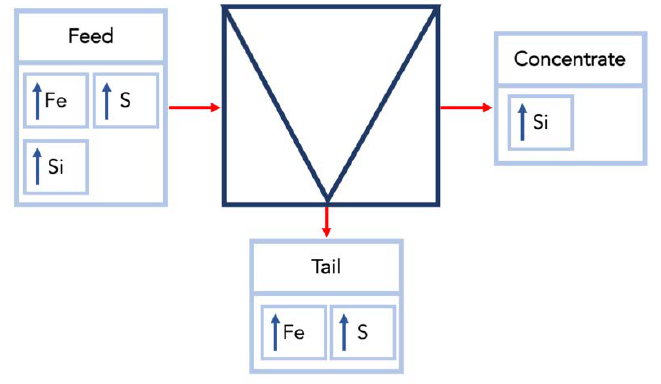
Figure 2. Scheme of reverse flotation process carried out in this study.